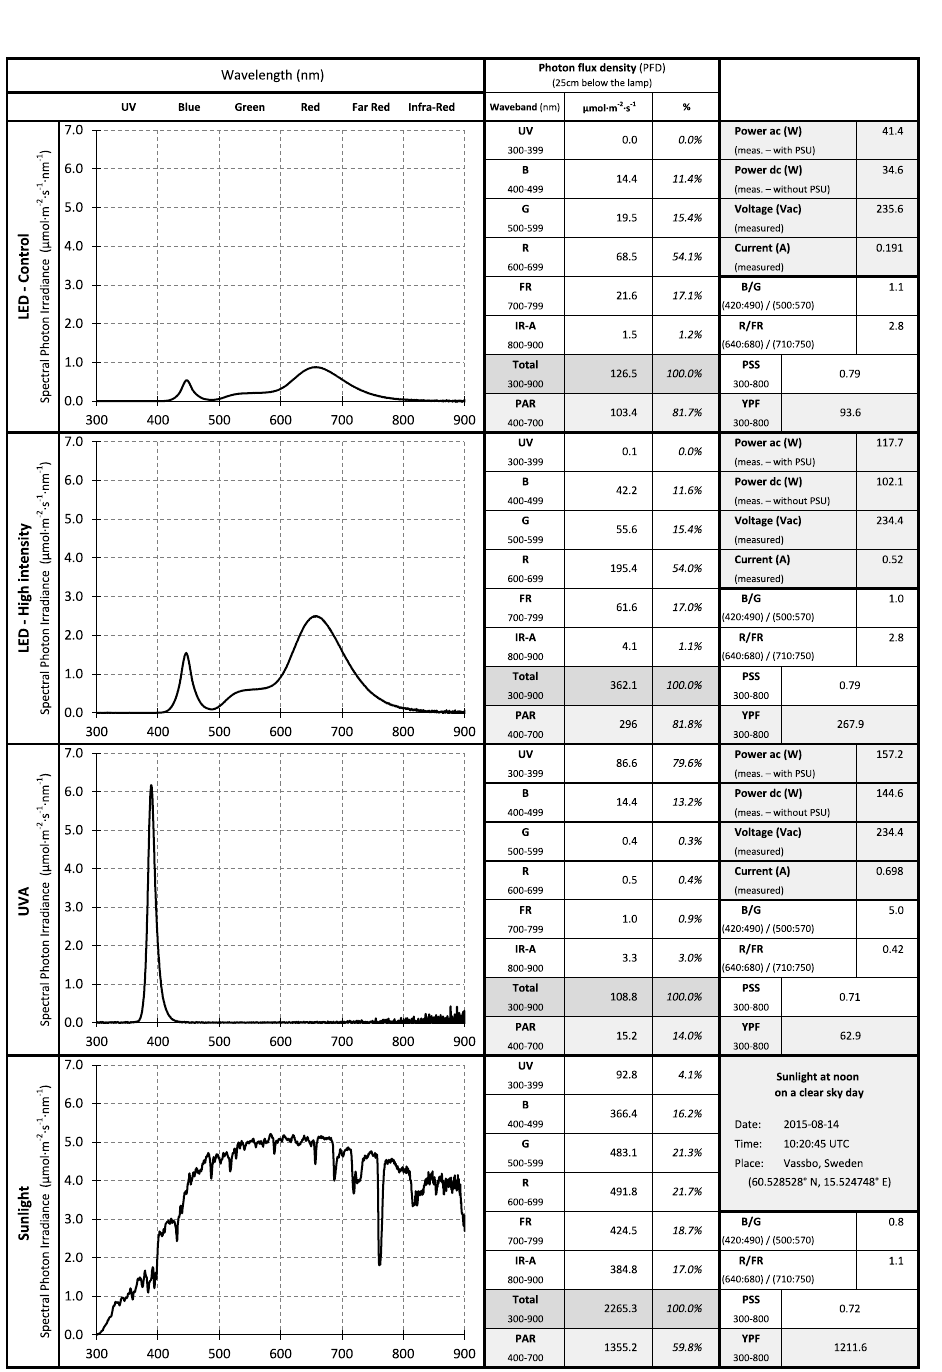
Figure 1. Spectral characteristics of the light sources used, that is LED lamps at base level for indoor control cultivation (100 μ mol·m − 2 ·s − 1 ), LED lamps for high intensity treatment (300 μ mol· m − 2 ·s − 1 ) and LED lamp for ultraviolet A (UVA) treatment. The figure shows the Photon Flux Density (PFD), waveband distribution, Photosynthetically Active Radiation (PAR) and electrical characteristics when measured 25 cm directly below the lamps.